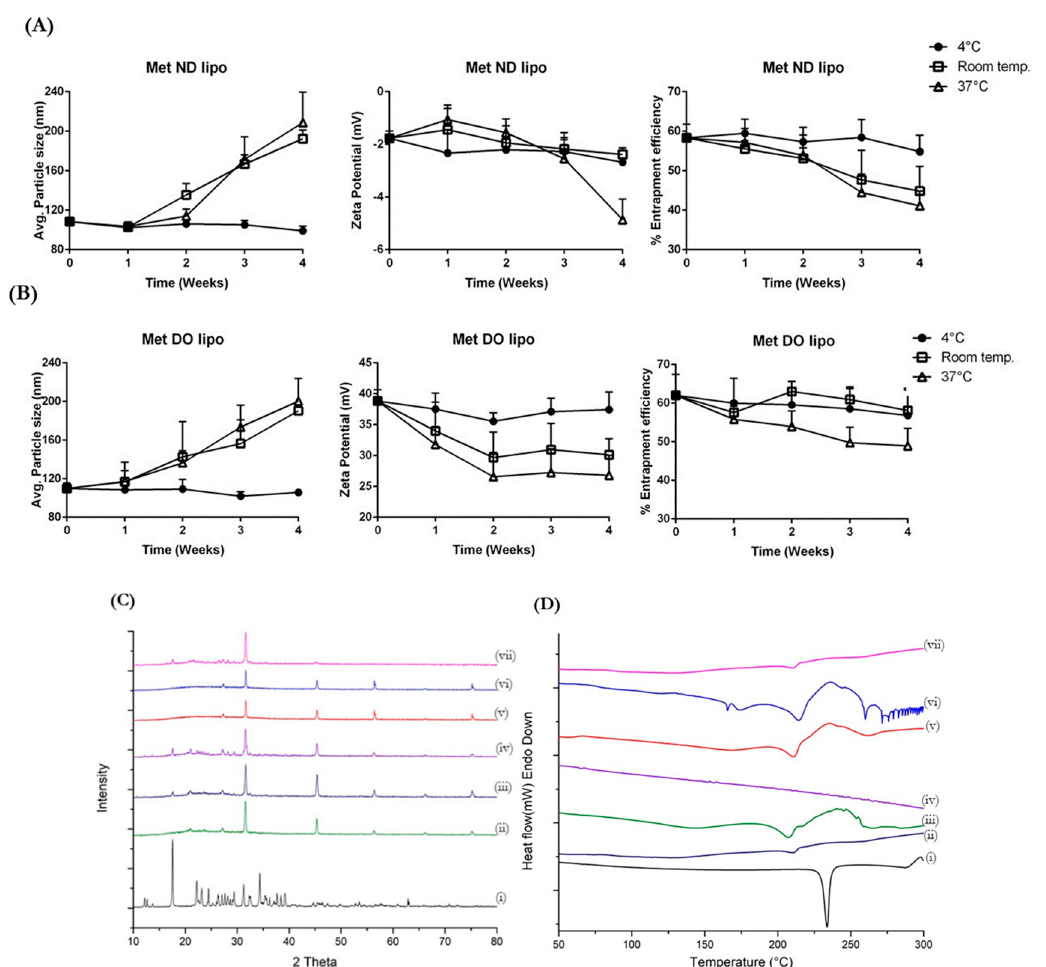
Figure 3. Stability of liposomal formulations evaluated at different temperatures; 4 °C, room temperature (~25 °C), and 37 °C, expressed as mean particle size, zeta potential, and % entrapment efficiency. ( A ) Stability of Met ND lipo and ( B ) Met DO lipo evaluated for various parameters over period of four weeks. ( C ) Accelerated stability studies of liposomal formulations performed at 40 °C/75% RH for 45 days analyzed using PXRD and ( D ) DSC. (i) Met hydrochloride; (ii) Met ND lipo at 4 °C; (iii) Met ND lipo at Room temperature; (iv) Met ND lipo at 37 °C; (v) Met DO lipo at 4 °C; (vi) Met DO lipo at Room temperature; and (vii) Met DO lipo at 37 °C. Data represent mean ± SD ( n = 3).